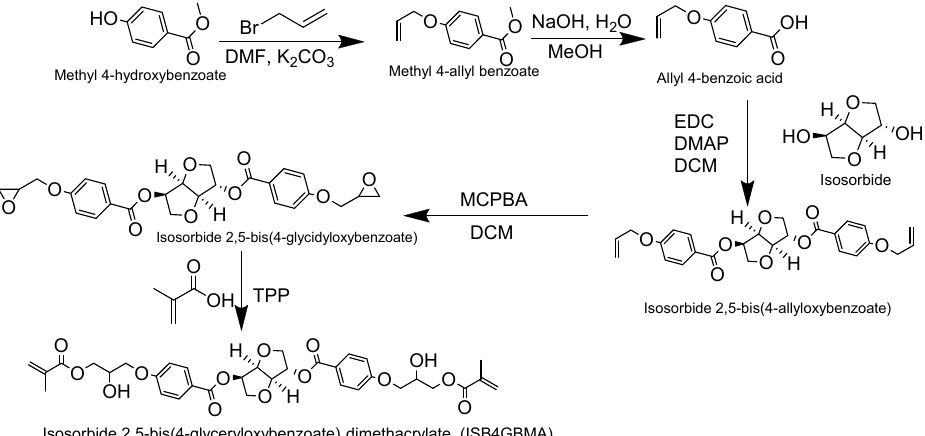
Figure 4. Reaction scheme for ISB4GBMA (1,4:3,6-dianhydro- D -sorbitol 2,5-bis [4